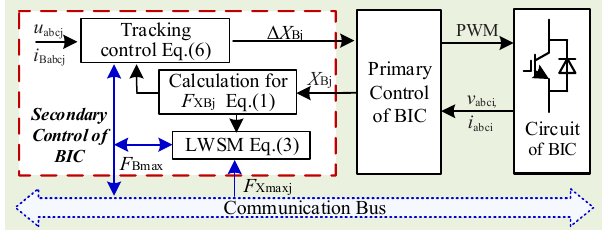
Figure 7. Control scheme of BIC.